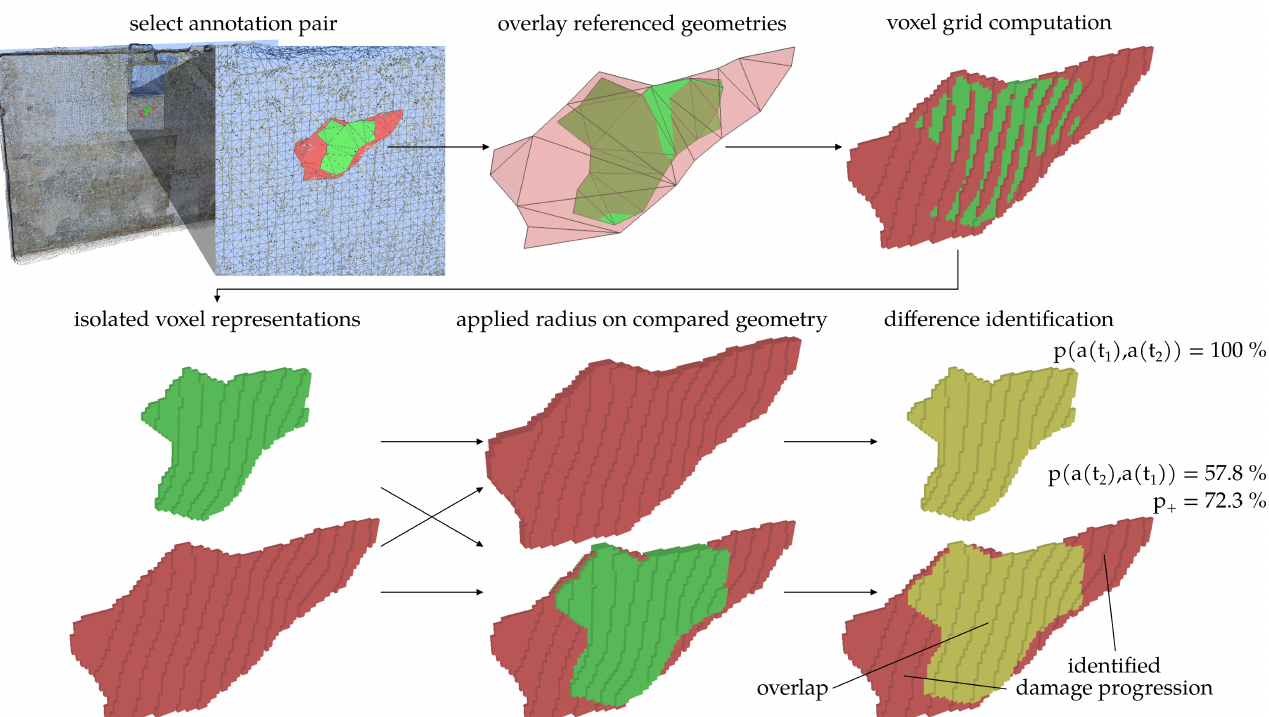
Figure 8. Voxel-based assignment and comparison of the exemplary damage from t 1 (green) and t 2 (red) in the dataset of Wall 02 using the parameters d v = 0.5cm and r v = 1, resulting in an identified overlap (yellow) and a damage growth of